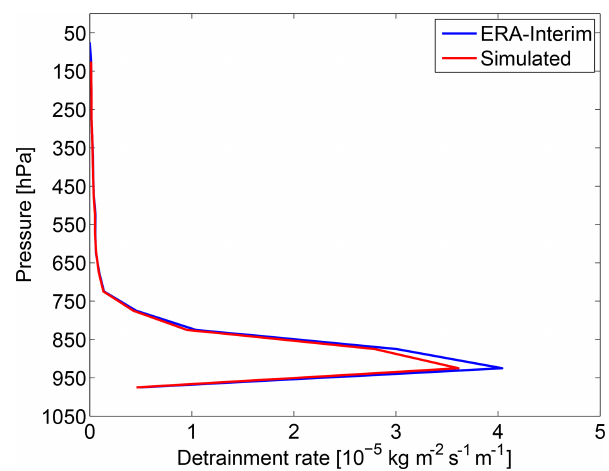
Figure 9. Mean convective mass flux profile from ERA-Interim compared to the simulated convective mass flux profile for forward trajectories and using a constant convective area fraction profile (in a region from 180 to 240 ◦ E and 30 ◦ S to 30 ◦ N; 20d with meteoro- logical fields of 1 June 2010 at 00:00UTC).